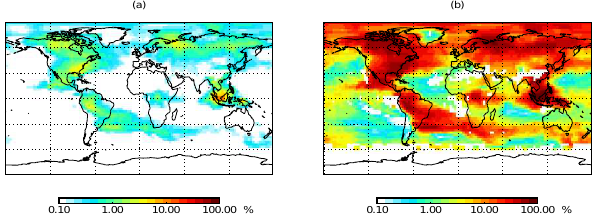
Figure 6. Percentage of immersion freezing simulated to be due to PBAPs (bacteria and fungal spores) in July 2000 at (a) 260K and (b) 263K. Values are for the upper limit contribution of PBAPs to immersion freezing and are weighted by ice cloud fraction (see